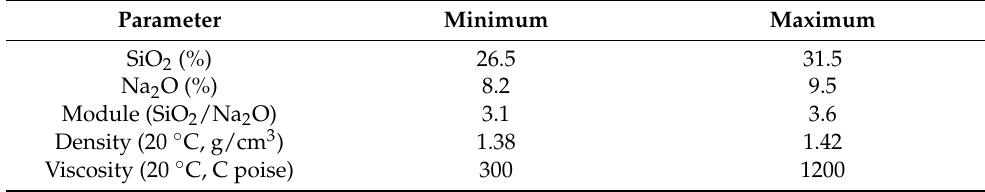
Table 3. Properties of Na 2 SiO 3 obtained from the supplier.